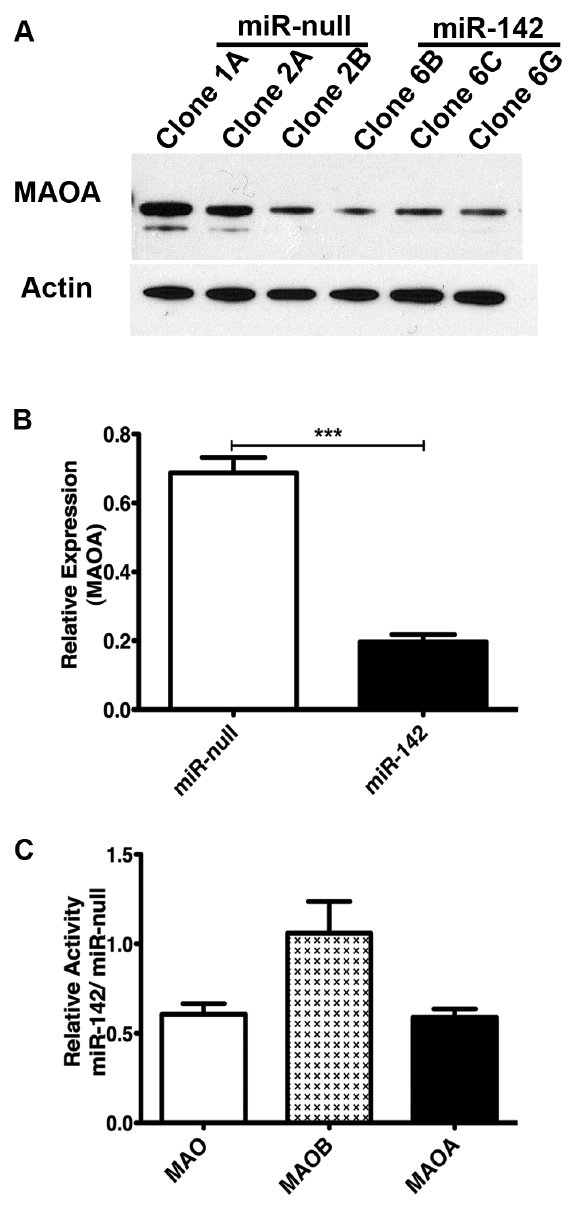
Figure 1. miR-142 downregulates MAOA protein expression and enzyme activity in BE(2)M17 cells. (A) Representative Western blot for MAOA in stable BE(2)M17 clones expressing miR-142 and in control miR-null clones. (B) Quantification of three independent Western blots showing that MAOA protein level is lower (-3.5 fold) in stable BE(2)M17 clones expressing miR-142 compared to miR-null clones. Blots were normalized to b -actin and unpaired t-test was performed. *** represent p , 0.001, error bars are standard error of mean. (C) Total MAO as well as MAOA and MAOB specific activity was measured in the miR-142 and miR-null BE(2)M17 clones. Both total MAO and MOA specific activity was approximately 40% lower in miR-142 clones compared to miR-null clones. There was no difference in MAOB specific activity. Y-axis represents fold change of enzyme activity, error bars represent standard error of mean, n=3.